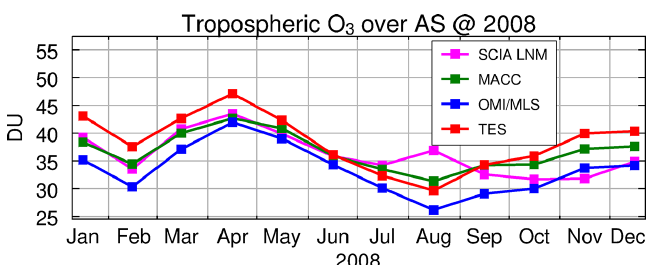
Figure A3. TOC results over AS from SCIAMACHY Limb-Nadir-Matching, OMI/MLS, TES, and MACC reanalysis data sets in